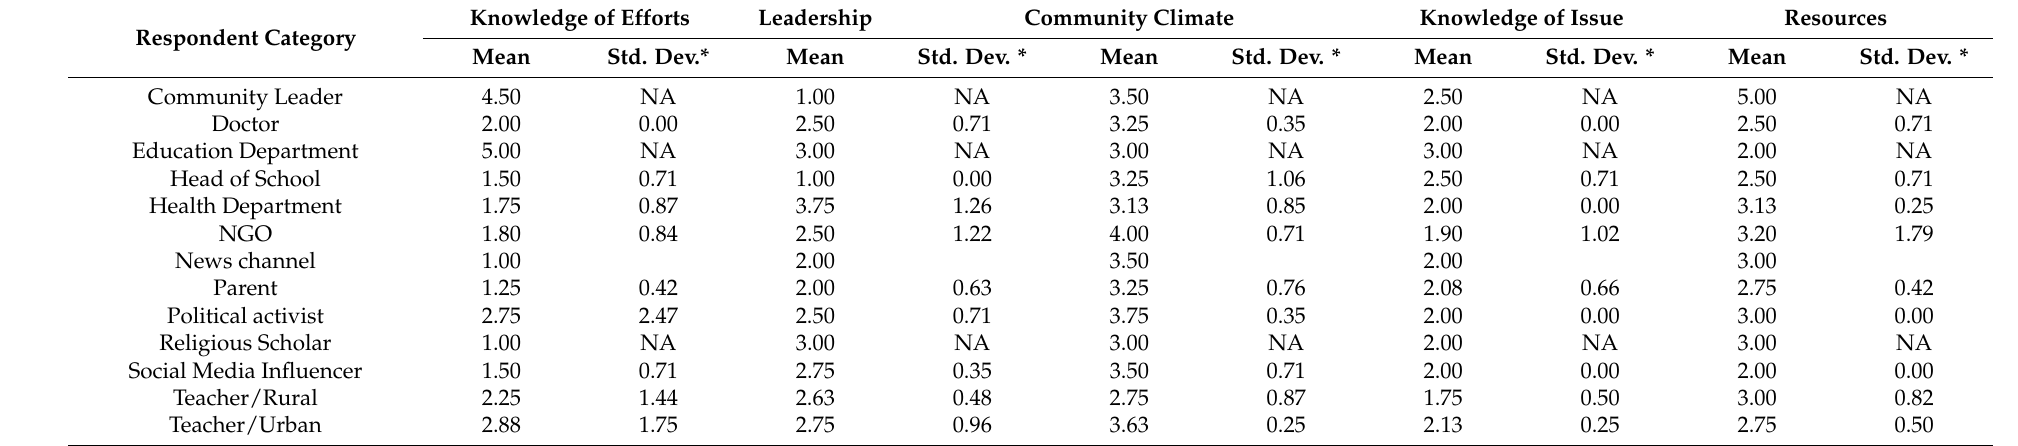
Table A2. Descriptive statistics of community readiness dimensions by respondent